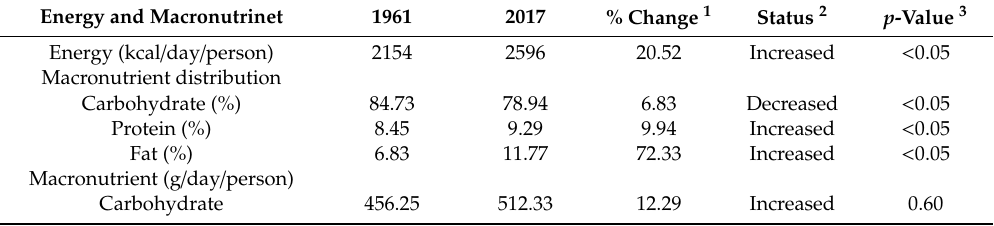
Table 1. Apparent consumption of energy and macronutrient in Bangladesh, 1961–2017. Energy and